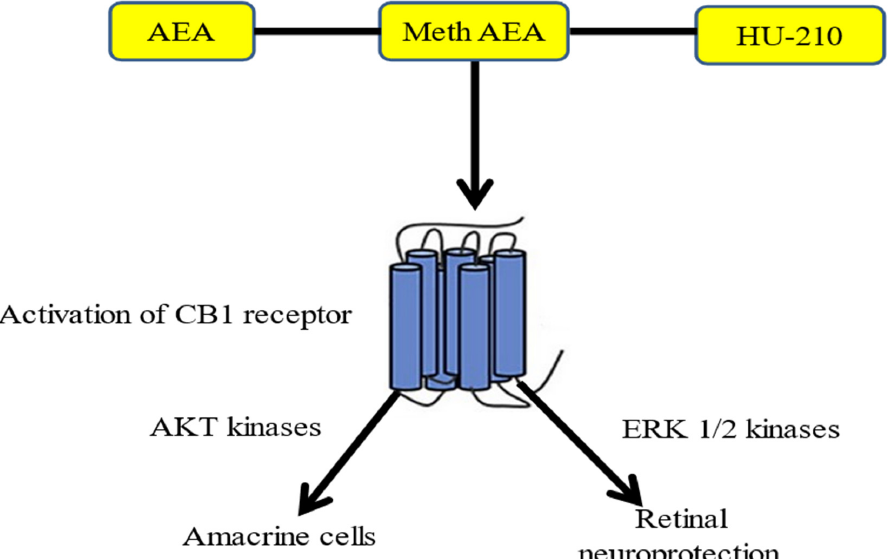
Figure 4. Mechanism of retinal neuroprotection (inhibition of the effect of different neurological diseases on the retina) by upregulating AEA/CB1/ERK ½ Kinases. AEA and AEA-like compounds activate CB1 receptors and provide retinal protection through the ERK kinases pathway.